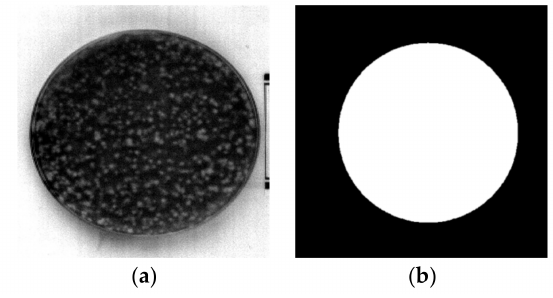
Figure 1. ( a ) Resized hyperspectral image; ( b ) mask for the hyperspectral